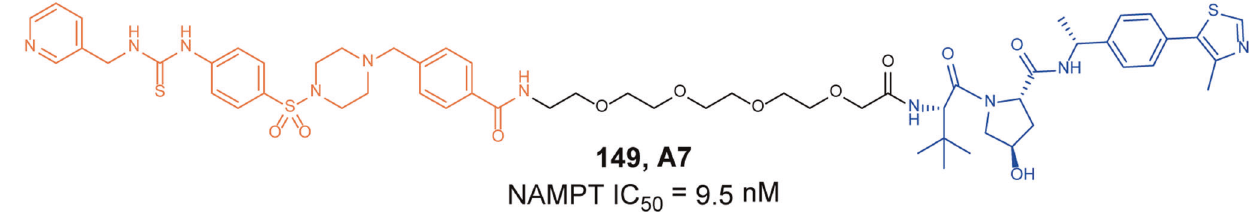
Fig. 35 The representative PROTAC targeting NAMPT